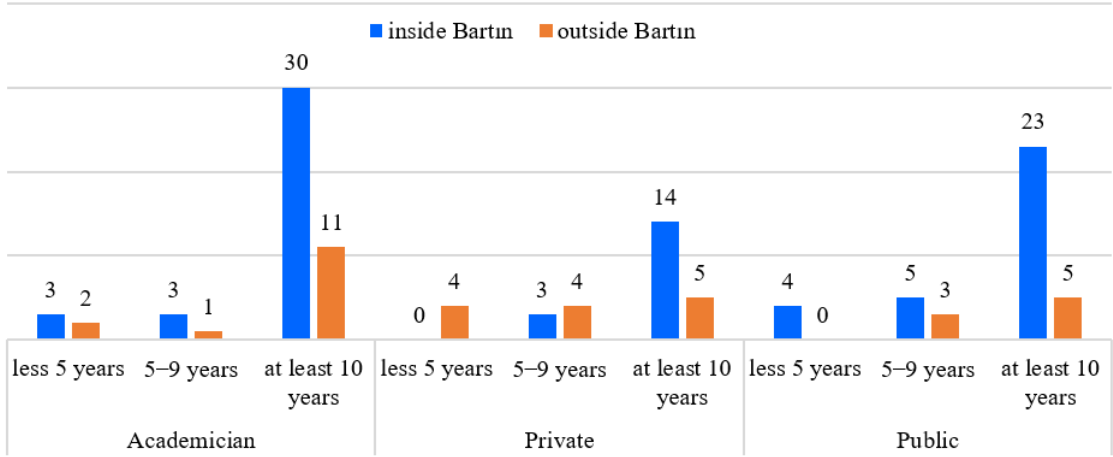
Figure 3. Distribution of the participants in terms of Specialization/Expertise and Professional ex- perience.